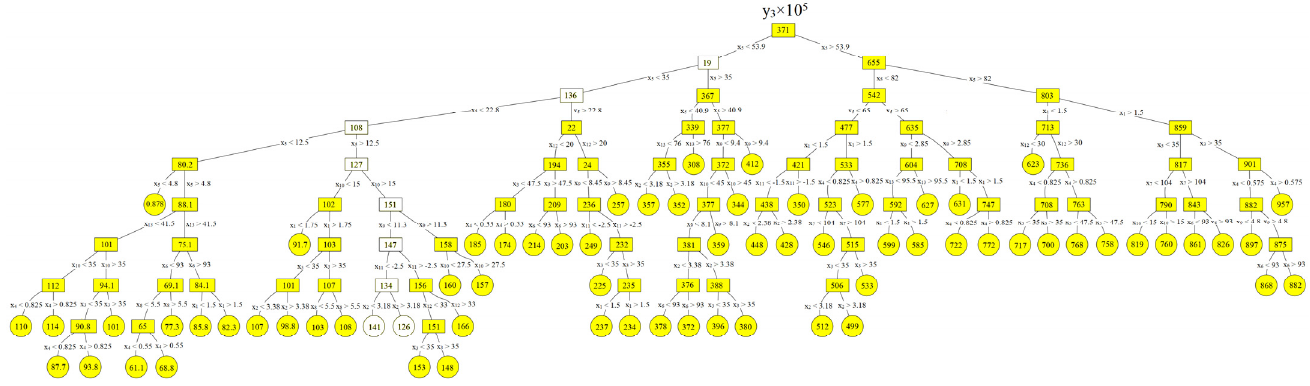
Figure 7. Regression tree analyzing the dependence of the ratio of the growth rate over axial temperature gradient in crystal y 3 × 10 5 (cm 2 /K min) on the furnace design and process parameters x 1 –x 13 . The mean values of y 3 in the nodes were rescaled by a factor of 1 × 10 5 to improve tree readability. In the case of doped Ge, the branches where leaf nodes have a mean y 3 ~1.34 × 10 -3 (cm 2 /K min) = 134 × 10 5 (cm 2 /K min) are favorable. The RMSE for each split is given in Table A2 in Appendix